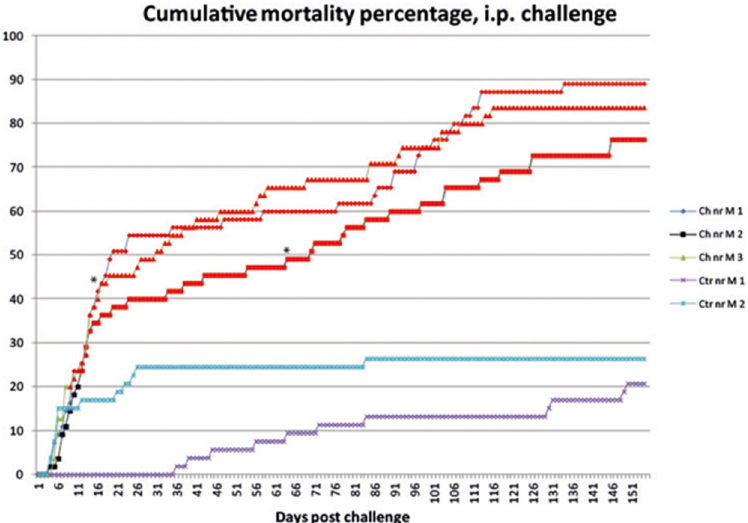
Figure 2. Cumulative mortality percentage of challenge (Ch nr) (n = 55 in each tank) and control (Ctr nr) (n = 53 in each tank) Atlantic cod ( Gadus morhua ) fish groups in experiment 1. M = fish groups used for mortality registrations only. Challenged groups are juvenile cod, ip injected with, respectively, 100 μ L virus suspension, containing VHSV isolate NO-2007-50-385, TCID 50 10 7.3 mL − 1 . Control fish were ip challenged with, respectively, 100 μ L BF-2 cell growth medium, containing lysed cells. Mortality data from challenged fish groups found significantly different from control group 1 are marked with a red colour ( p < 0.01). * = from that day onwards; mortality data from challenged fish groups were also significantly different from control group 2 ( p < 0.01, Bonferroni correction).